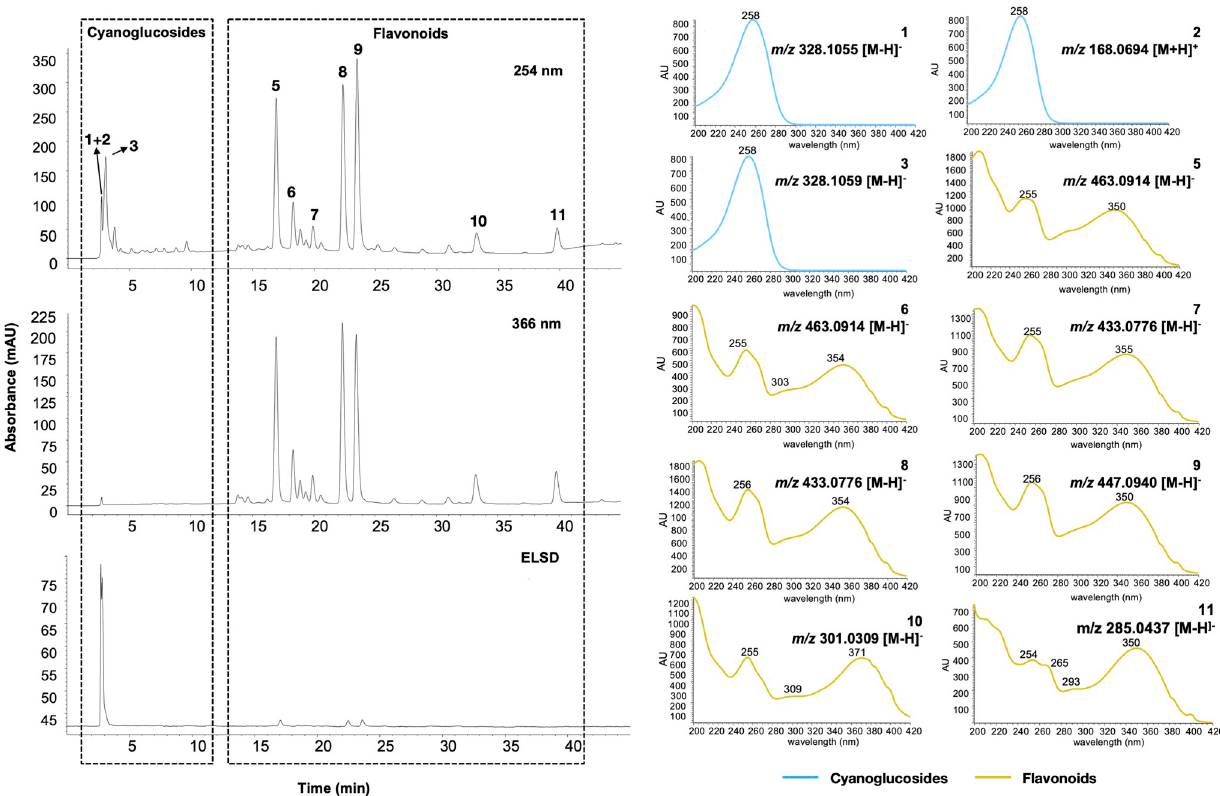
Fig 1. HPLC-PDA-ELSD analysis of the hydroalcoholic extract of Bauhinia holophylla leaves. Grey dark dashed rectangles represent the presence of cyanoglucoside derivatives (left) and the flavonoid derivatives (right) in the HPLC chromatogram. UV of each peak was obtained by HPLC-PDA analysis and molecular weight was determined by UHPLC-TOF-HRMS